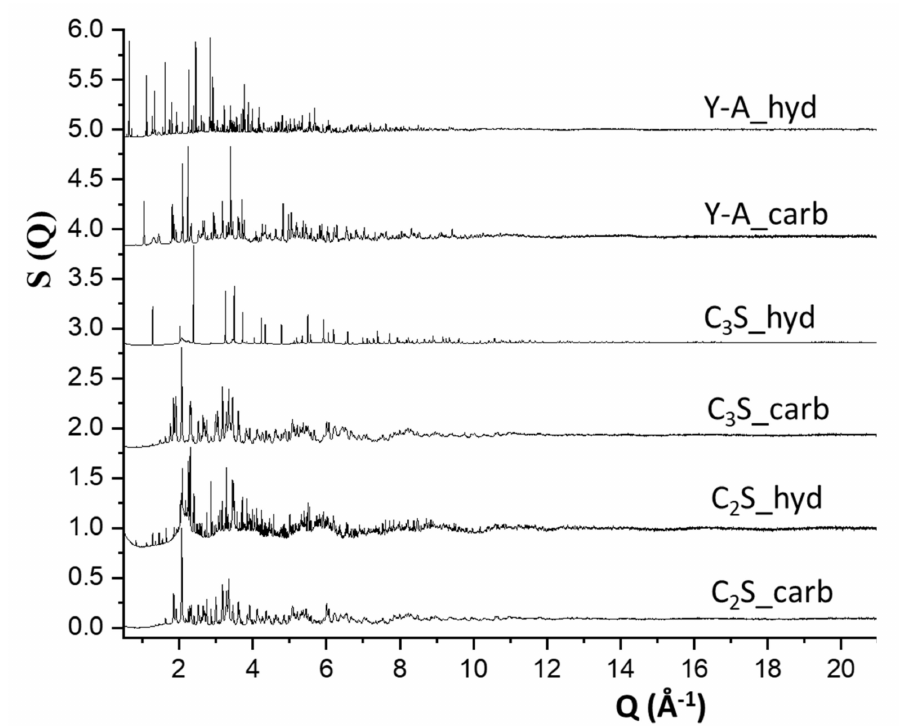
Figure 2. Synchrotron X-ray total scattering functions, S(Q), for the studied cement samples. The patterns were normalised with respect to their highest diffraction peaks and vertically displaced for adequate